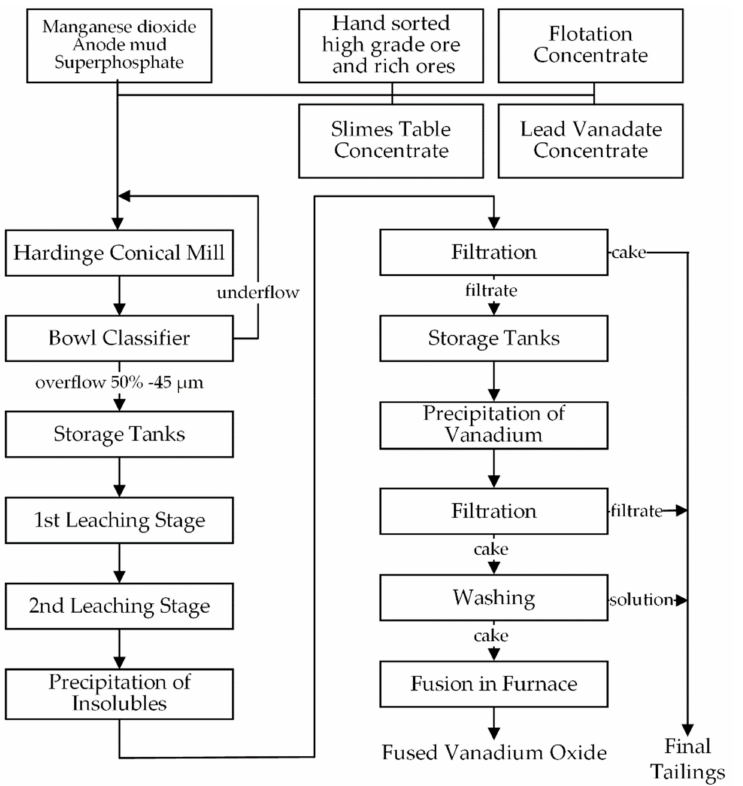
Figure 5. Flowsheet of vanadium leaching plant at Kabwe, Zambia